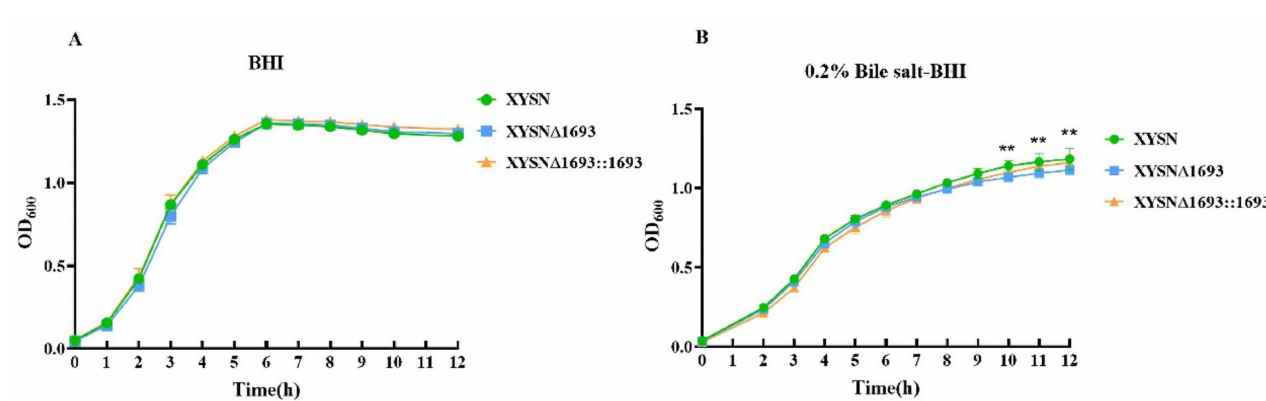
Figure 2. LMxysn_ 1693 gene participates in bile salt resistance of Lm. The fresh culture of wild type, LMxysn_ 1693 mutant and complemented strains were adjusted to OD 600 = 0.05, they were inoculated to BHI medium and 0.2% bile salt–BHI medium under 37 ◦ C, respectively. The